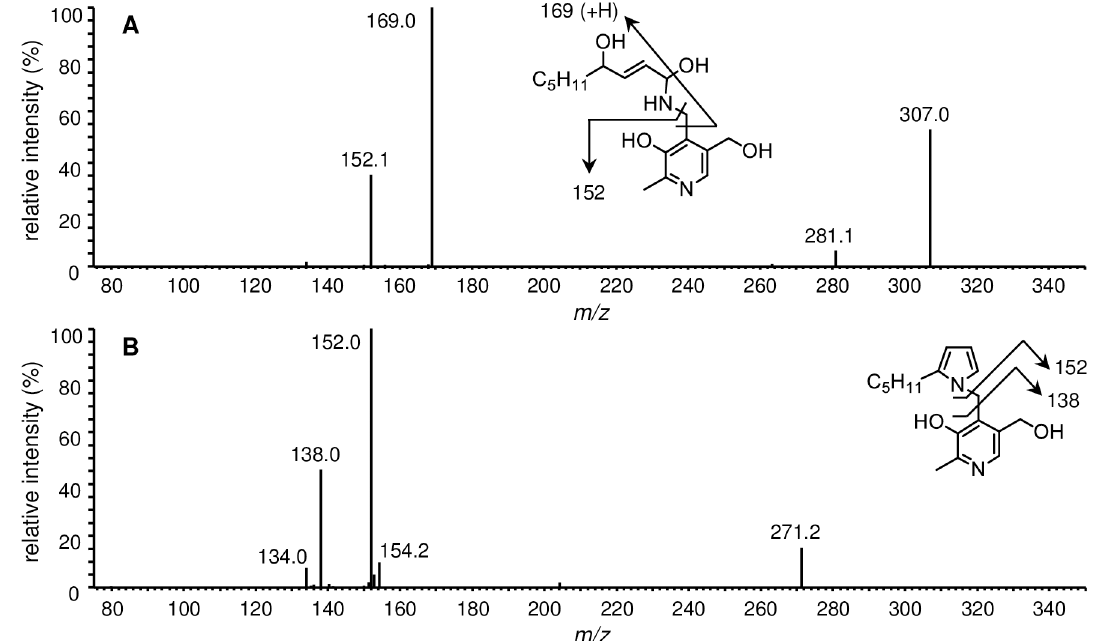
Fig 4. LC/ESI-MS/MS analysis of PM-HNE adducts (A) PH1 ( m/z 325.1) and (B) PH2 ( m/z 289.1).